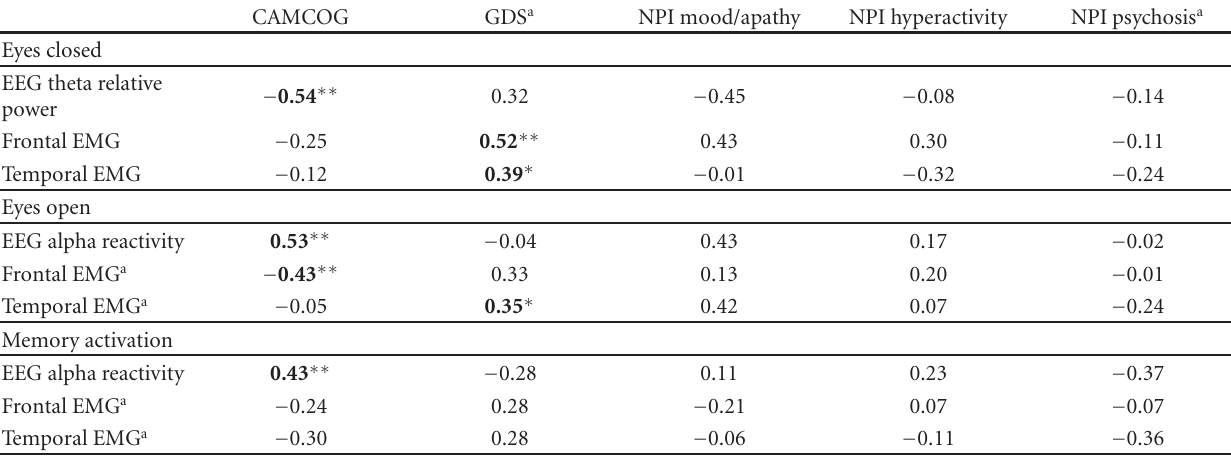
Table 3: Correlations between EEG and EMG activity on the one hand and cognitive and neuropsychiatric scores on the other hand. CAMCOG GDS a NPI mood/apathy